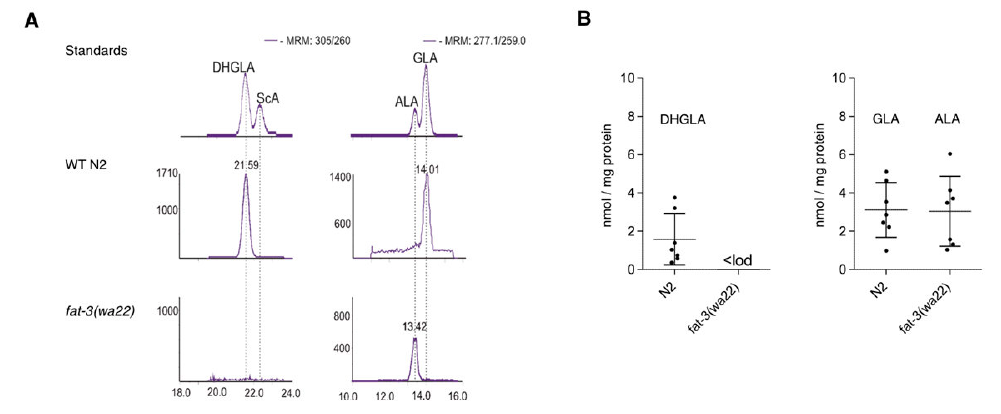
Figure 5. Detection of C20:3 and C18:3. ( A ) Detection of DHGLA, GLA and ALA in N2 (WT) and fat-3 ( wa22 ) animals; no ScA was detected in the fat-3 ( wa22 ) animals. ( B ) Corresponding quantification by LC-MS/MS of the mentioned C20:3 and C18:3. Data represent values from independent experiments. Scatter plots show mean ± SD.